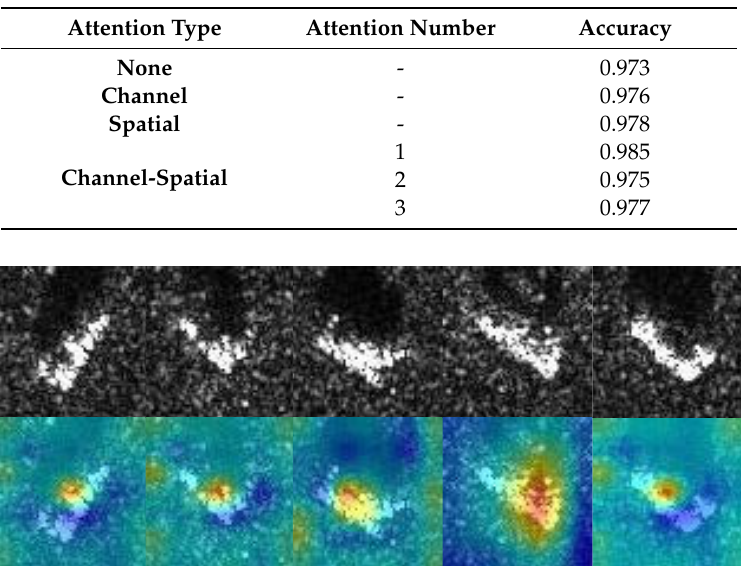
Table 3. Performance of attention module (ELU).